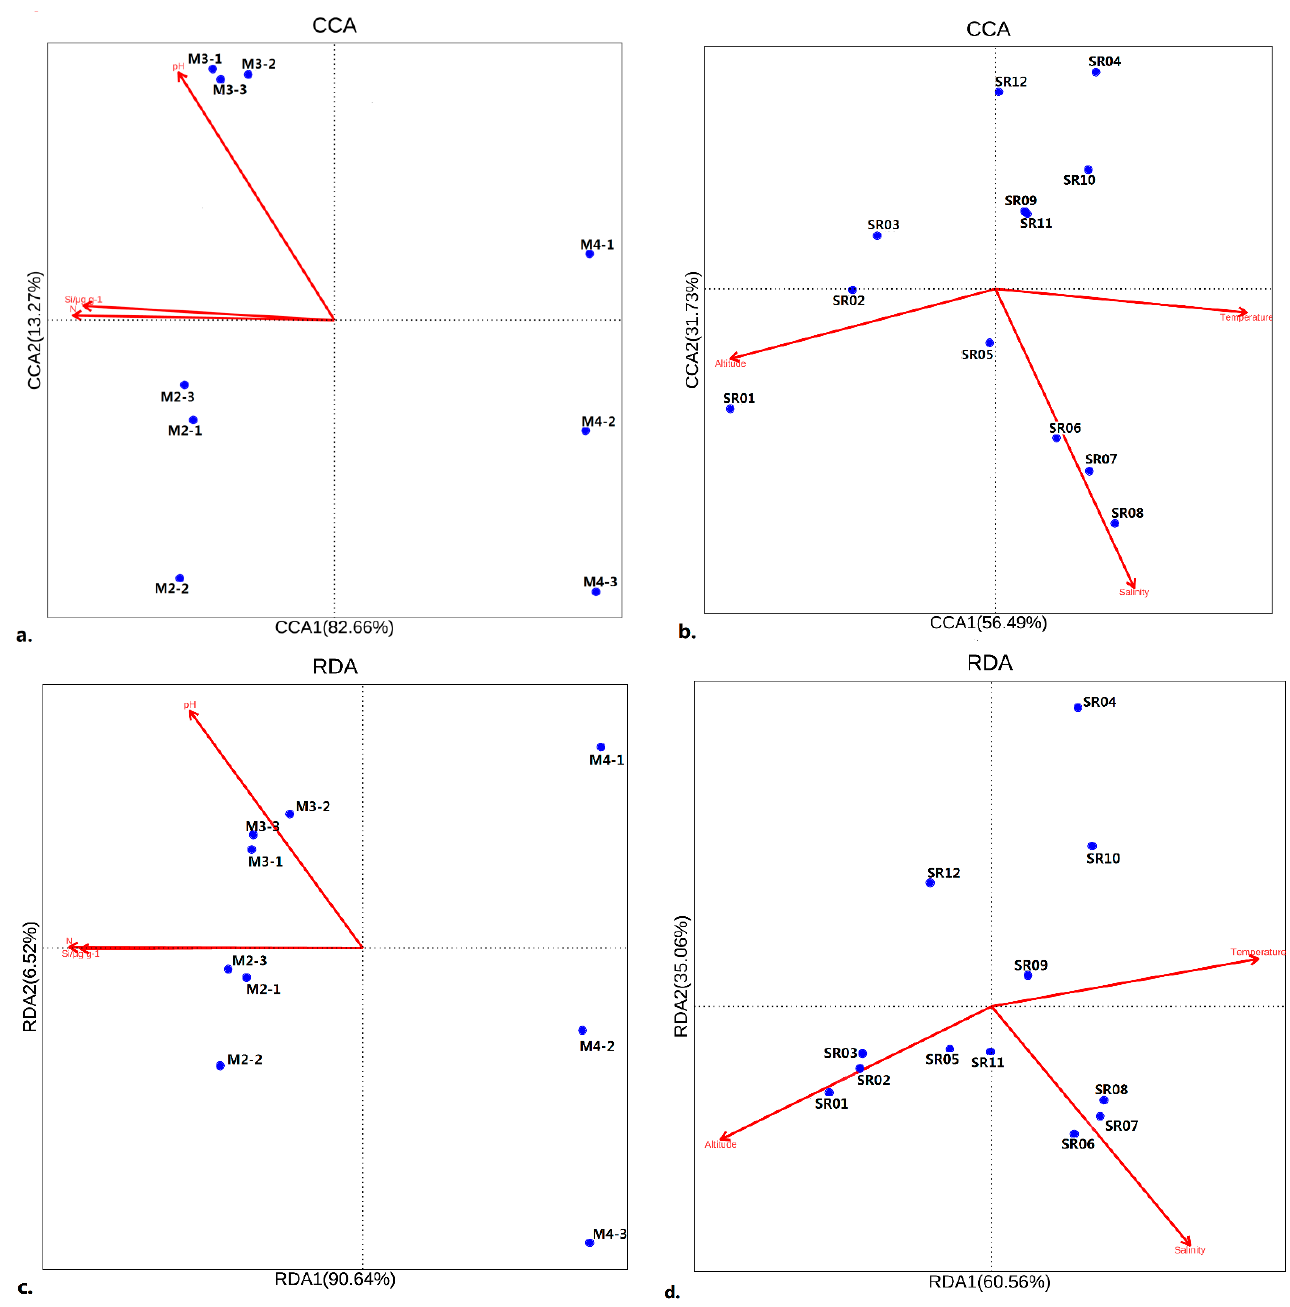
Figure 5. Relationships of microbial community structure at different sampling sites with physio- chemical factors in an ordination diagram with the first two axes of the canonical correspondence analysis (CCA) and redundant analysis (RDA). Red arrows with different lengths denote relative correlations of different independent variables with the community structure factors: ( a , b ) for prokaryote communities in soil and water samples, respectively; ( c , d ) for eukaryote communities in soil and water samples, respectively.